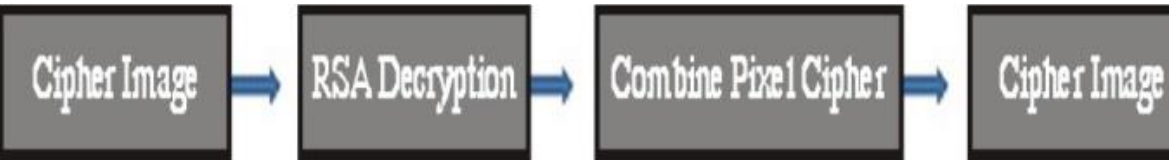
Figure 5. Decryption process of